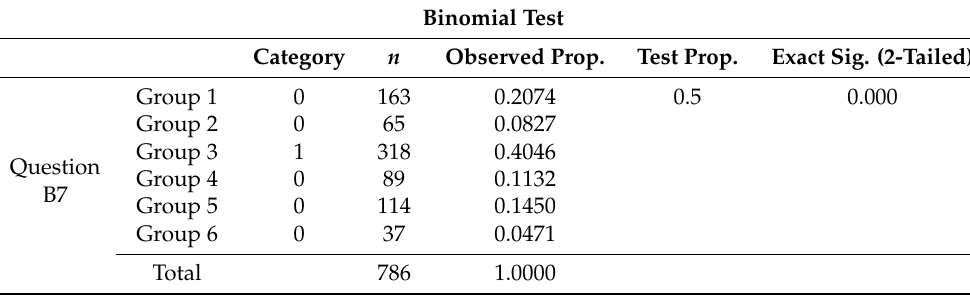
Table 3. Binomial test results for the hypothesis H2—WFEs.